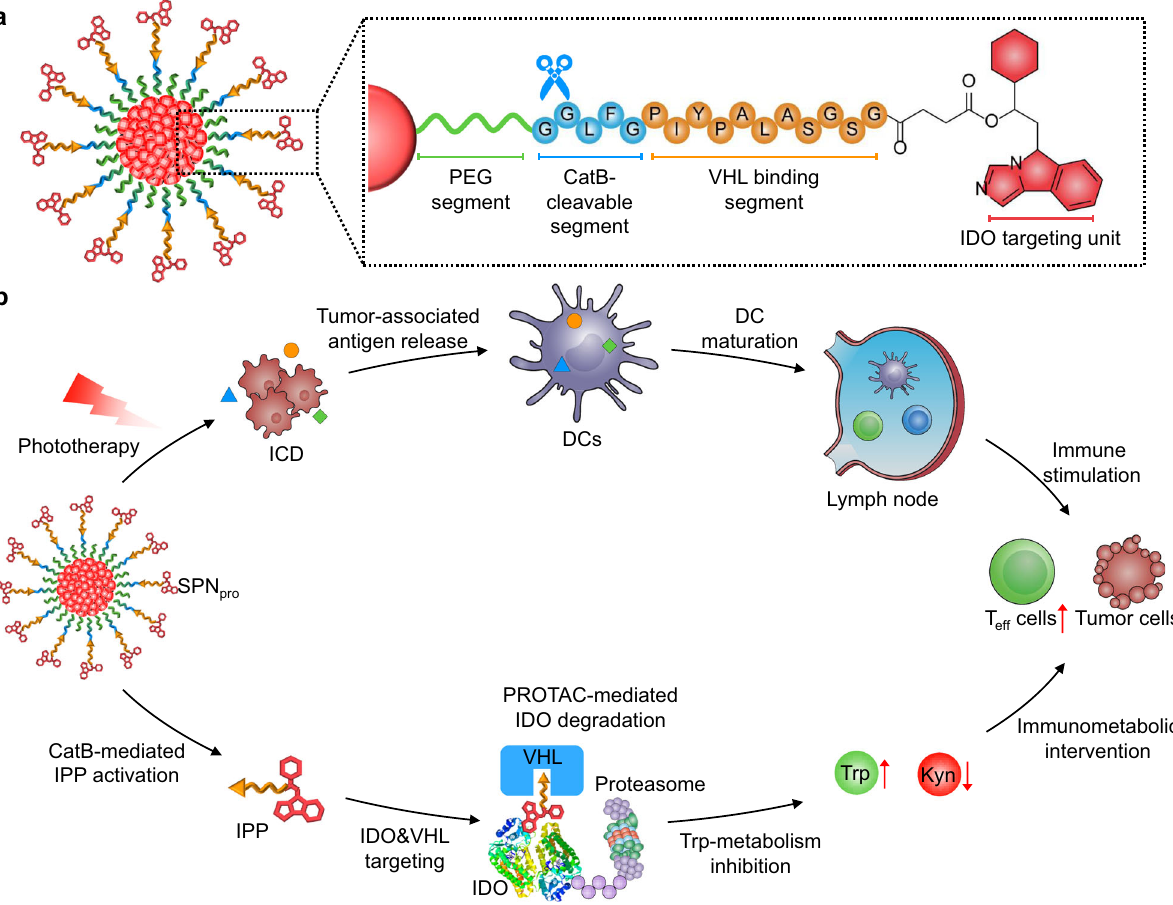
Fig. 1 Schematic illustration of SPN pro -mediated IDO degradation for cancer photo-immunometabolic therapy. a Structure and cathepsin B (CatB)- speci fi c activation mechanism of SPN pro . b SPN pro -mediated activatable photo-immunometabolic therapy with two processes: (i) a series of cancer immune responses including immunogenic cell death (ICD), tumor-associated antigen release, DC maturation, and effector T (T eff ) cell activation upon NIR photoirradiation; (ii) SPN pro -mediated immunometabolic intervention processes including CatB-speci fi c activation of IPP, IDO and VHL targeting, proteasome recruitment, IDO degradation, Trp upregulation and Kyn depletion, and T eff cell